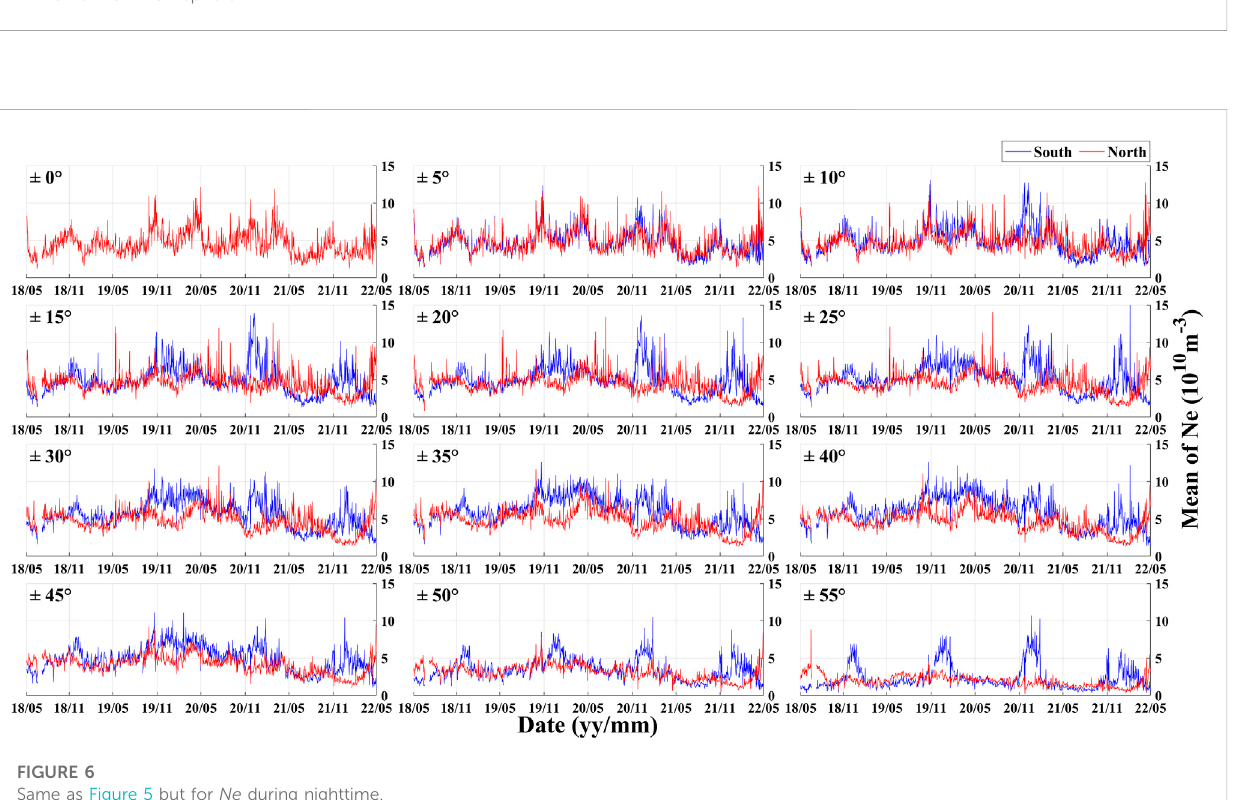
FIGURE 6 Same as Figure 5 but for Ne during